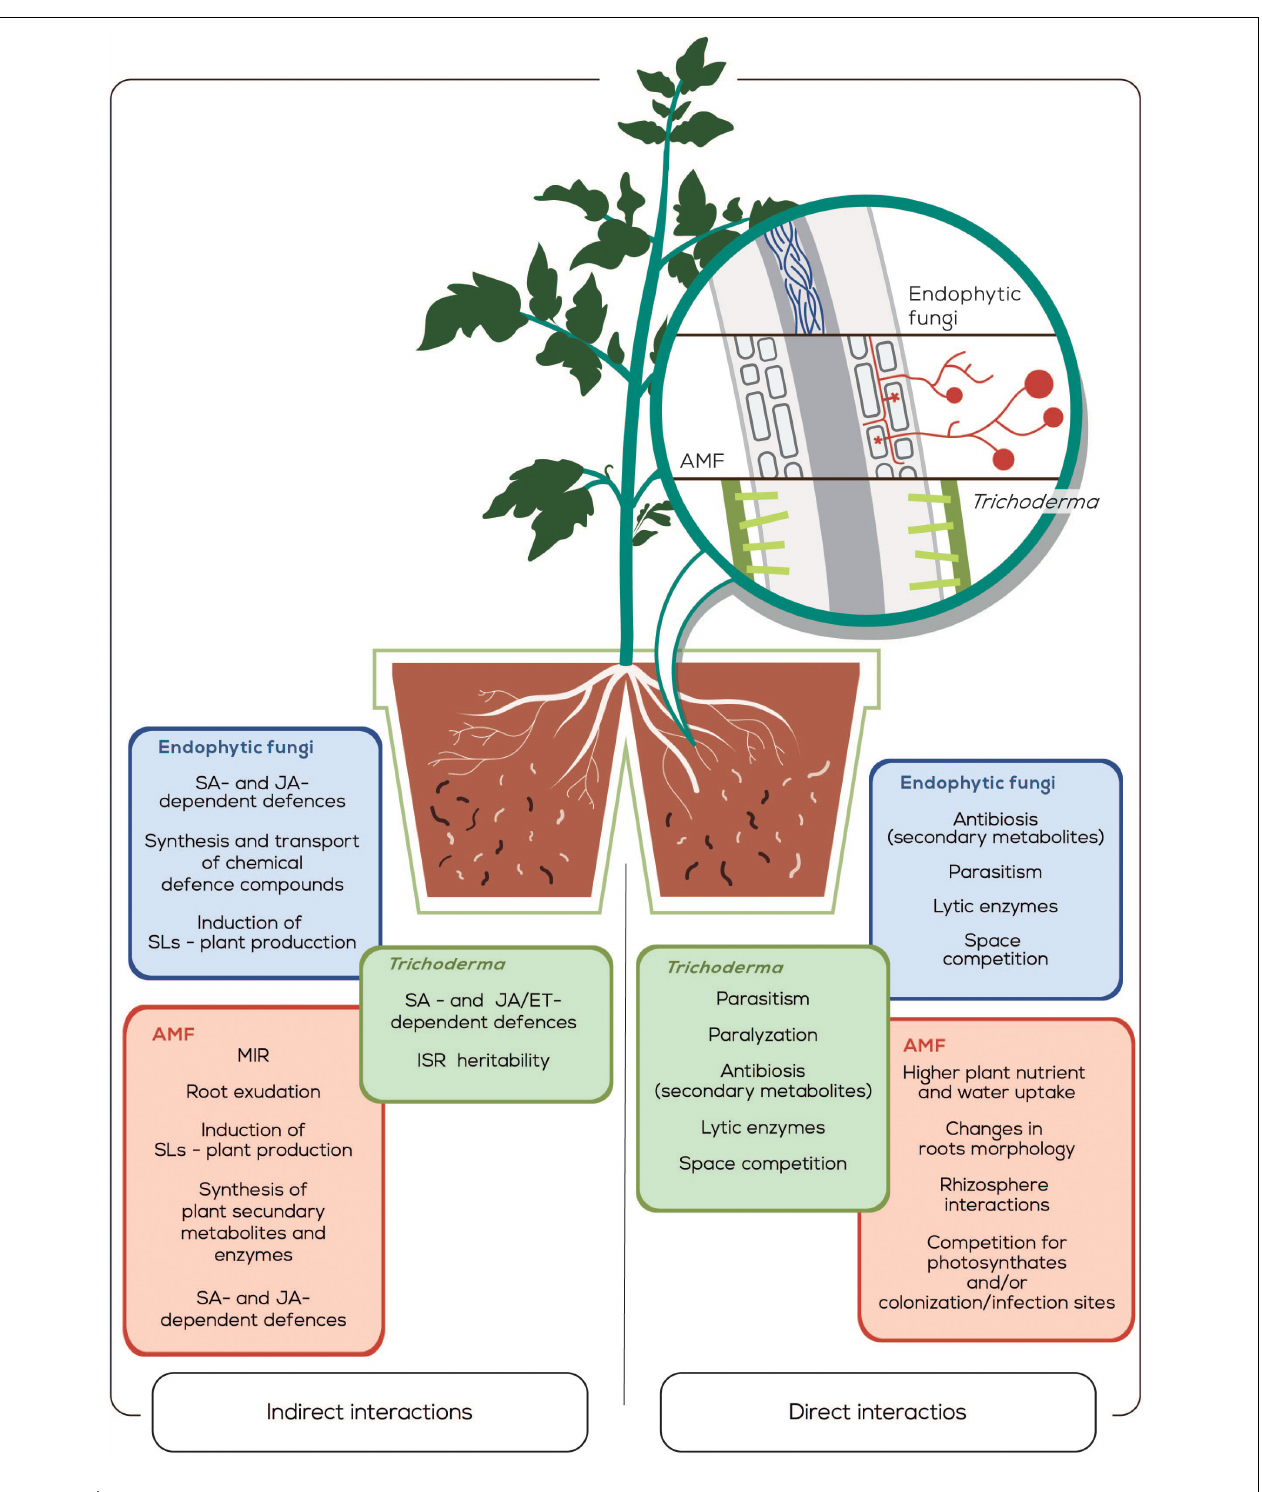
FIGURE 1 | Graphical representation of direct and induced resistance against plant-parasitic nematodes by filamentous fungi in a split-root system. The different tissue colonization strategies used by the three fungal groups are schematically represented in the microscopic enlargement of the roots. The mechanisms of fungus to induce resistance in plants either by direct or indirect interaction strategies against nematodes are indicated in colored boxes. The effects of the filamentous fungi on nematodes basically are: To increase J2 mortality, to decrease the hatching and/or nematodes infection rate, as well as to alter nematodes development inside the plant and/or their reproduction. Abbreviations correspond to arbuscular mycorrhizal fungi (AMF), salicylic acid (SA), jasmonic acid (JA), systemic acquired resistance (SAR), induced systemic resistance (ISR), strigolactones (SLs), and mycorrhizal induced resistance (MIR).